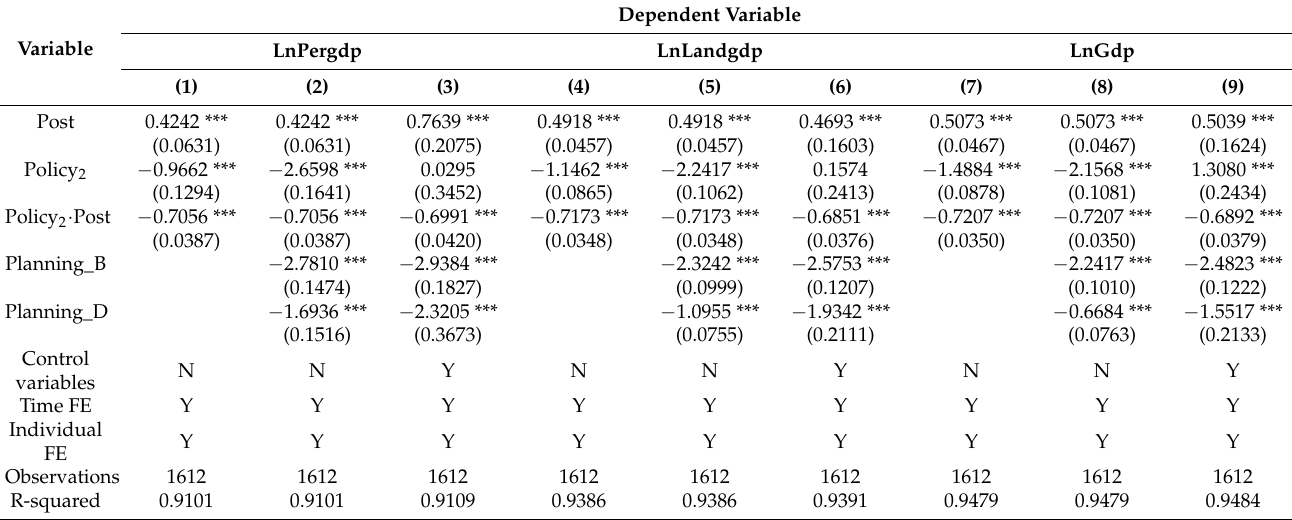
Table 5. Regression results after redefining the treated